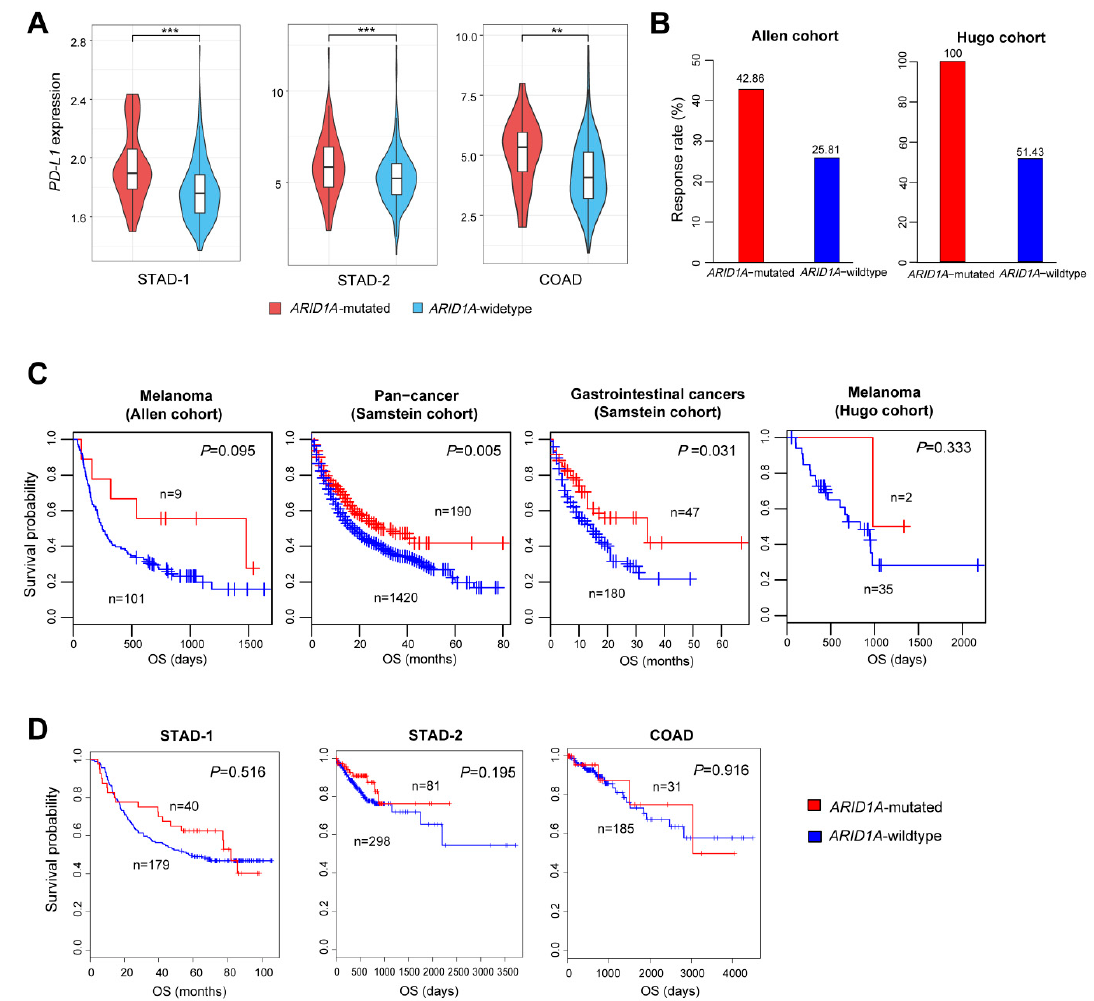
Figure 4. ARID1A mutations are associated with elevated PD-L1 expression in GI cancers and favorable immunotherapy response in cancer. ( A ) ARID1A -mutated GI cancers have significantly higher PD-L1 expression levels than ARID1A -wildtype GI cancers (Student’s t test, P < 0.01). * P < 0.05, ** P < 0.01, *** P < 0.001. ( B ) ARID1A mutations are associated with increased immune checkpoint blockade therapy response rate in two melanoma cohorts (Allen cohort [3] and Hugo cohort [31]). ( C ) Kaplan-Meier survival curves show that ARID1A -mutated cancers have a better overall survival (OS) than ARID1A -wildtype cancers in the immunotherapy setting in three cohorts (Allen cohort [3], Hugo cohort [31], and Samstein cohort [32]). ( D ) Kaplan-Meier survival curves show that the ARID1A mutation exhibits no significant correlation with OS in the three GI cancer cohorts (STAD-1, STAD-2, and COAD) untreated with